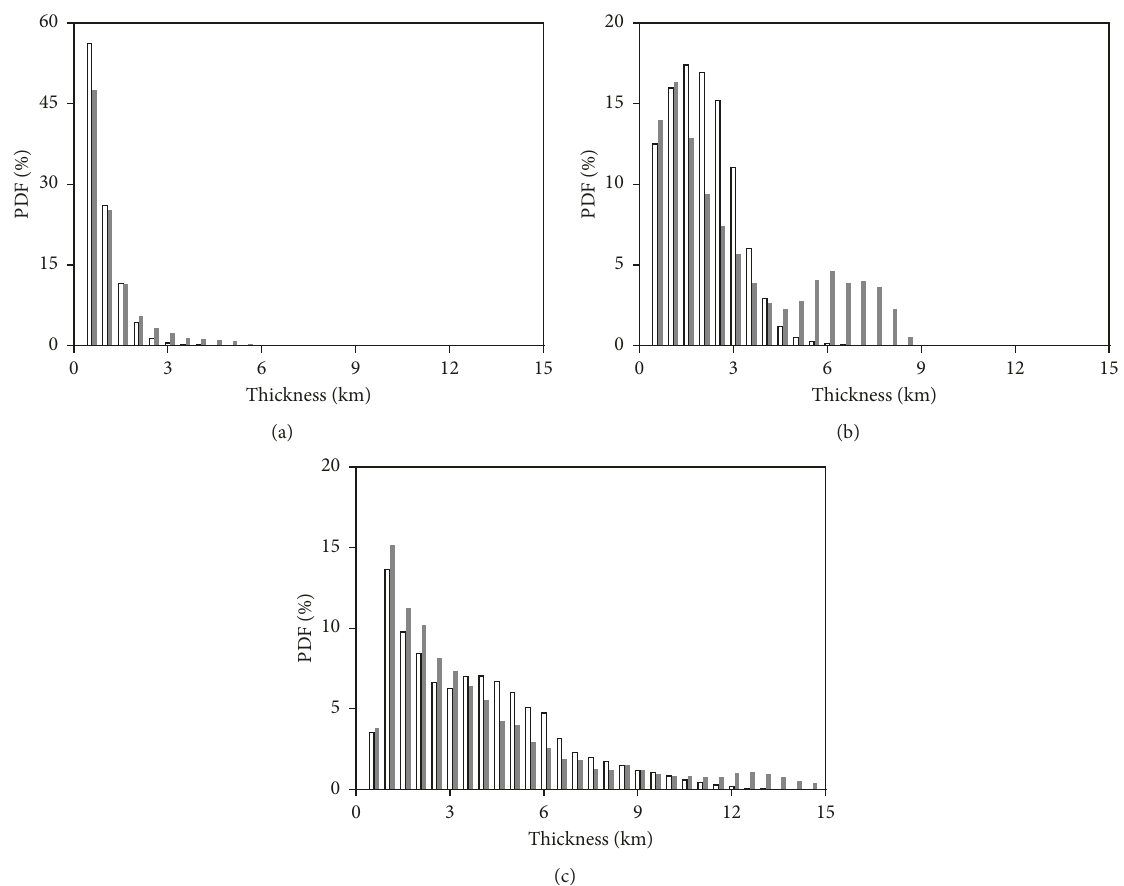
Figure 7: Probability density of thickness for (a) warm clouds, (b) mixed-phase clouds, and (c) ice clouds. Table 1: Occurrence of multilayered clouds (%). Region Clear sky Single-layered Two-layered Three-layered